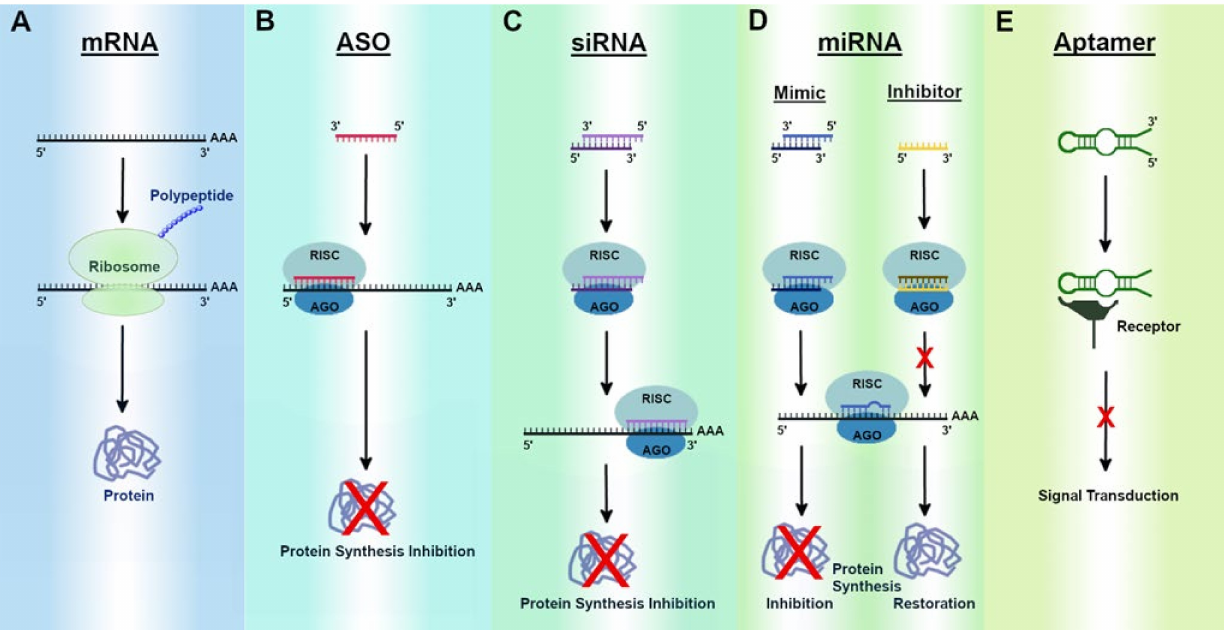
Figure 1. Schematic of RNA therapeutic approaches. ( A ) Ribosomes translate mature mRNAs into proteins, the building blocks for life. ( B ) ASOs are small single-stranded RNA molecules that have exact complementarity to a target mRNA. Once bound, they induce post-transcriptional gene silencing by preventing translation of the mRNA. ( C ) siRNAs are small double-stranded RNA molecules that have exact complementarity to a target mRNA. Once associated with the RISC complex, it binds to its target mRNA and induces gene silencing by preventing translation of the mRNA. ( D ) miRNA mimics are small double-stranded RNA molecules that associate with and guide the RISC complex to its target mRNA. The mimic will bind with imperfect complementarity to its target mRNA, and translation will be blocked or the mRNA will be degraded leading to gene silencing. miRNA inhibitors are small single-stranded RNAs that bind to and suppress their target miRNA. This results in restored mRNA translation. ( E ) Aptamers are RNA, DNA, or RNA/DNA hybrids that form tertiary structures and bind to a target molecule, either suppressing or enhancing the pathway that the target molecule is involved